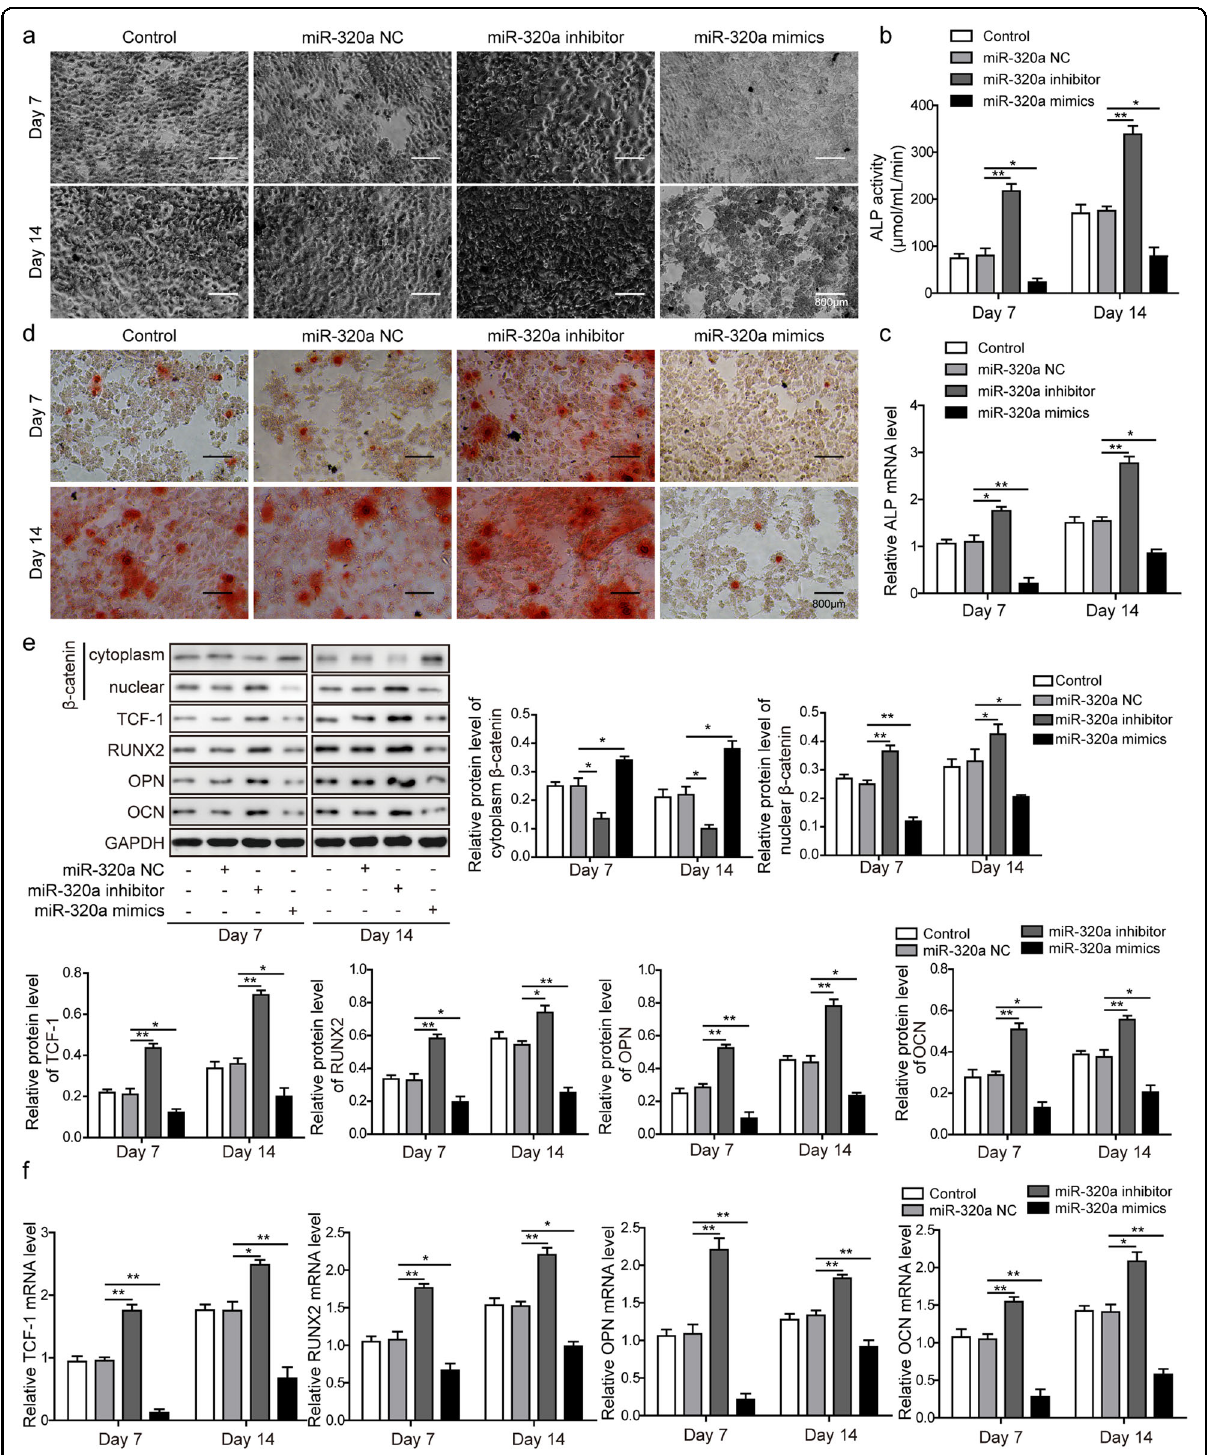
Fig. 4 MiR-320a downregulated osteogenic differentiation and inhibited the β -catenin signaling pathway. Osteogenic differentiation was evaluated at days 7 and 14 by staining the cells with a ALP or d Alizarin Red. The cells were observed under an inverted microscope. b The staining results were further con fi rmed by ALP activity quanti fi cation. c qRT-PCR was performed to evaluate the mRNA expression of ALP. e Western blotting was performed to evaluate the expression of β -catenin in the cytoplasm and nucleus, TCF-1, RUNX2, OPN, and OCN. f Relative mRNA levels of TCF-1, RUNX2, OPN, and OCN upon lentiviral infection were determined by qRT-PCR. BMSCs were infected with lentivirus encoding miR-320a inhibitor or mimics or with empty viruses, and cells were collected and lysed at day 7 and day 14. All experiments were conducted independently at least three times. * P < 0.05 and ** P <